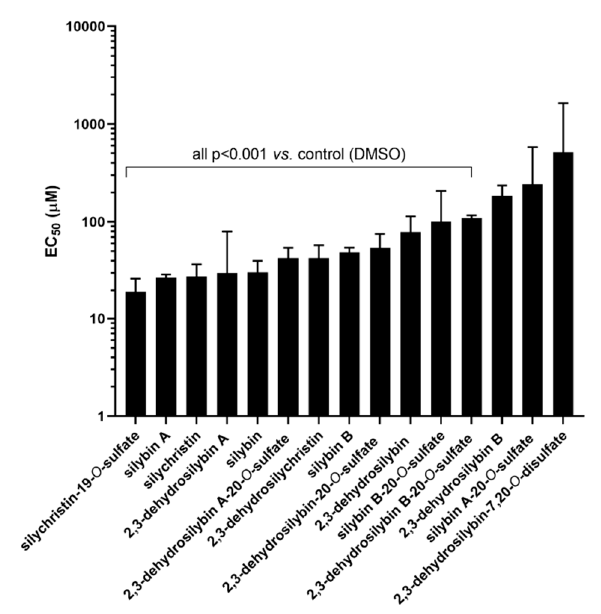
Figure 3. Ex vivo vasorelaxant effects of silymarin flavonolignans on intact rat aortic rings precontracted with phenylephrine. Data are expressed as EC 50 values, with the error reflecting the 95% confidence interval; n = 4 with the exception of silychristin and 2,3-dehydrosilybin A-20- O -sulfate ( n = 5); 2,3-dehydrosilybin A ( n = 6); and 2,3-dehydrosilybin B-20- O -sulfate and 2,3-dehydrosilybin B ( n = 3).